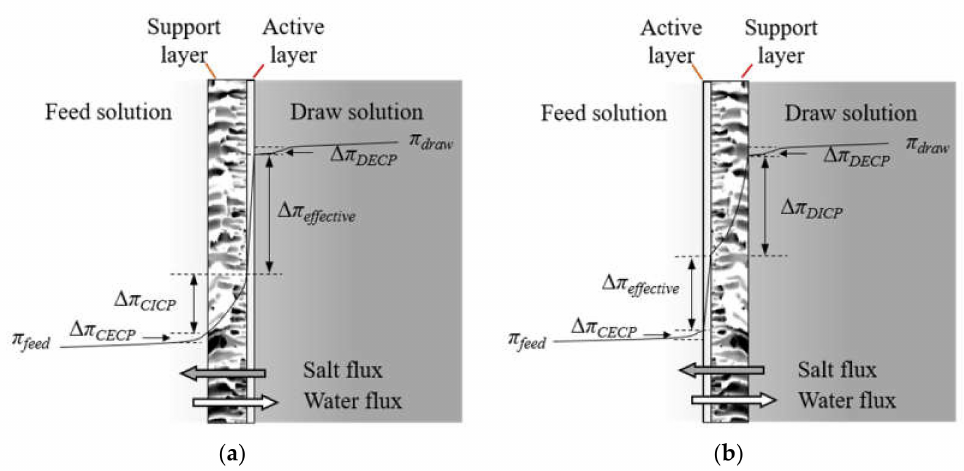
Figure 1. Schematic illustration of osmotic pressure profile across the membrane in osmotically-driven membrane processes. ( a ) Active-layer-facing-draw-solution (AL-DS) mode. ( b ) Active-layer-facing-feed-solution (AL-FS) mode. ∆ π effective is the effective osmotic pressure difference. ∆ π CICP , ∆ π DICP , ∆ π CECP , and ∆ π DECP are the osmotic pressure difference loss caused by concentrative internal concentration polarization (ICP), dilutive ICP, concentrative external concentration polarization (ECP), and dilutive ECP